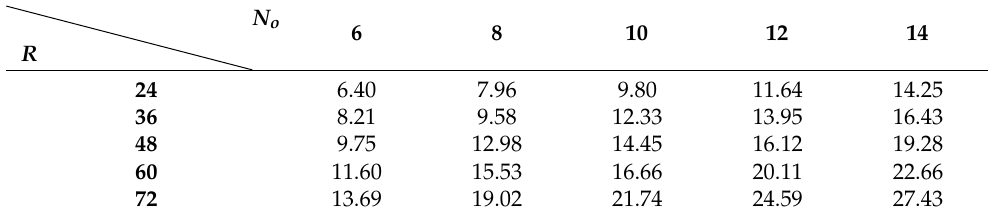
Table 4. RT with different parameter